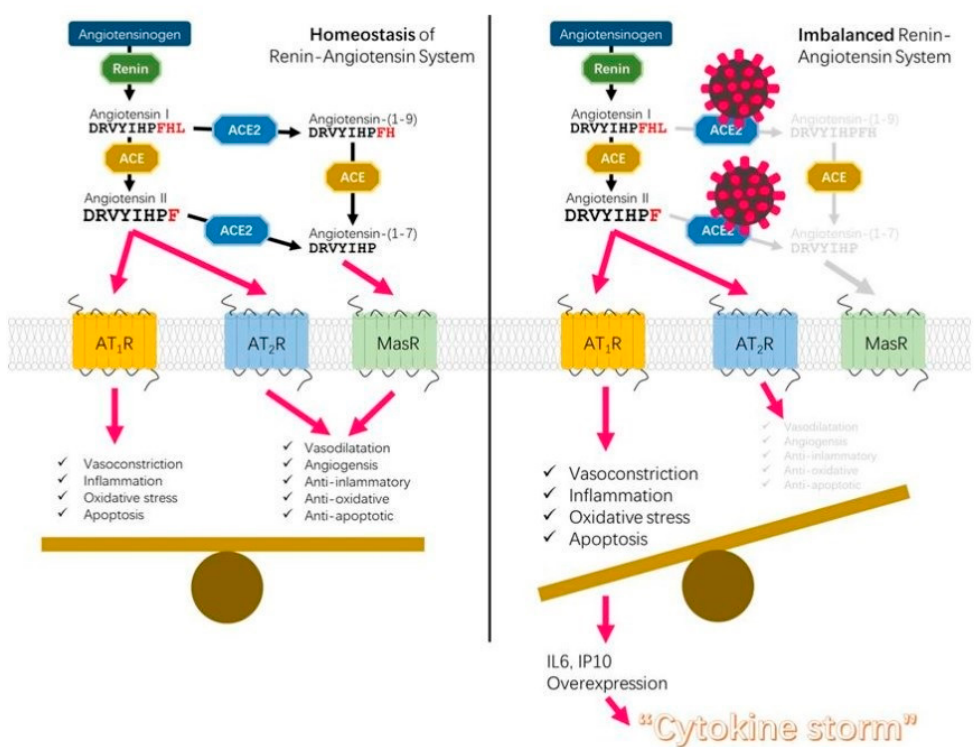
Figure 1. A comprehensive scheme of the interactions between the molecules involved in the renin- angiotensin system (RAS) from [3], copyright 2020 by Gang Niu. Reprinted with